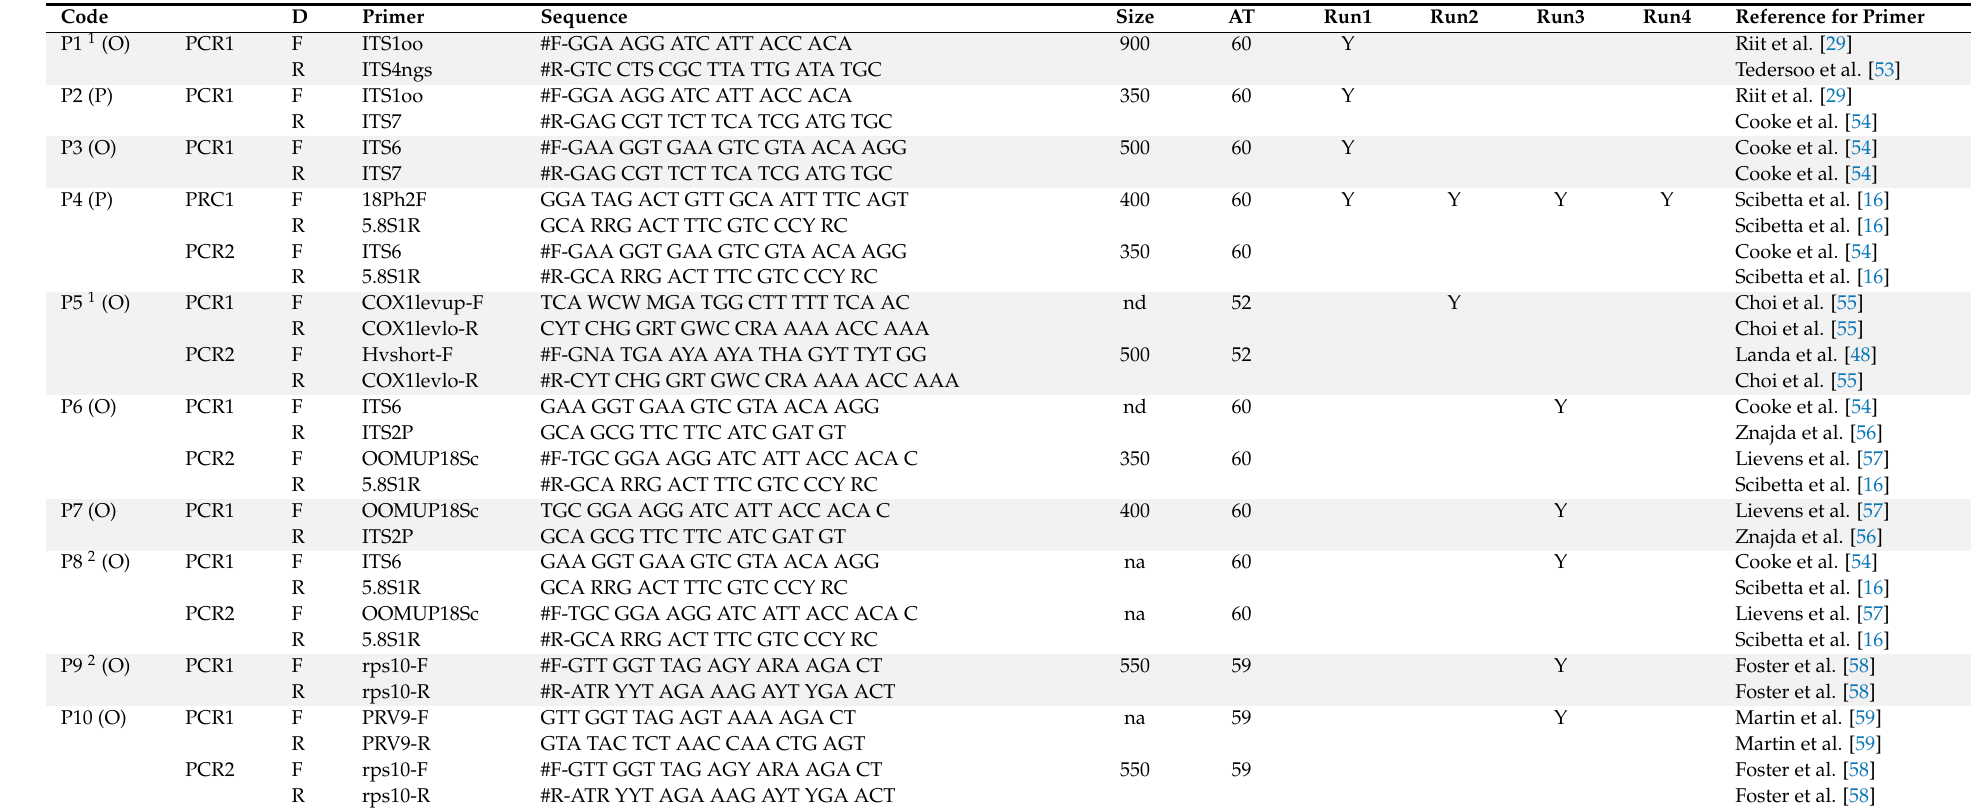
Table 2. Details of the primers used in four separate metabarcoding runs. Primers sets were coded P1 to P21. Nested PCR was conducted for primer sets P4, P5, P6, P8, and P11. Primer sets P14–21 were not tested, but were included as they related to the studies presented in Table 1. Amplicon size including primers (size) and the annealing temperature (AT) of the PCR reaction are also provided for primers used in the current study. Primer set P4 was included in all the runs for comparison